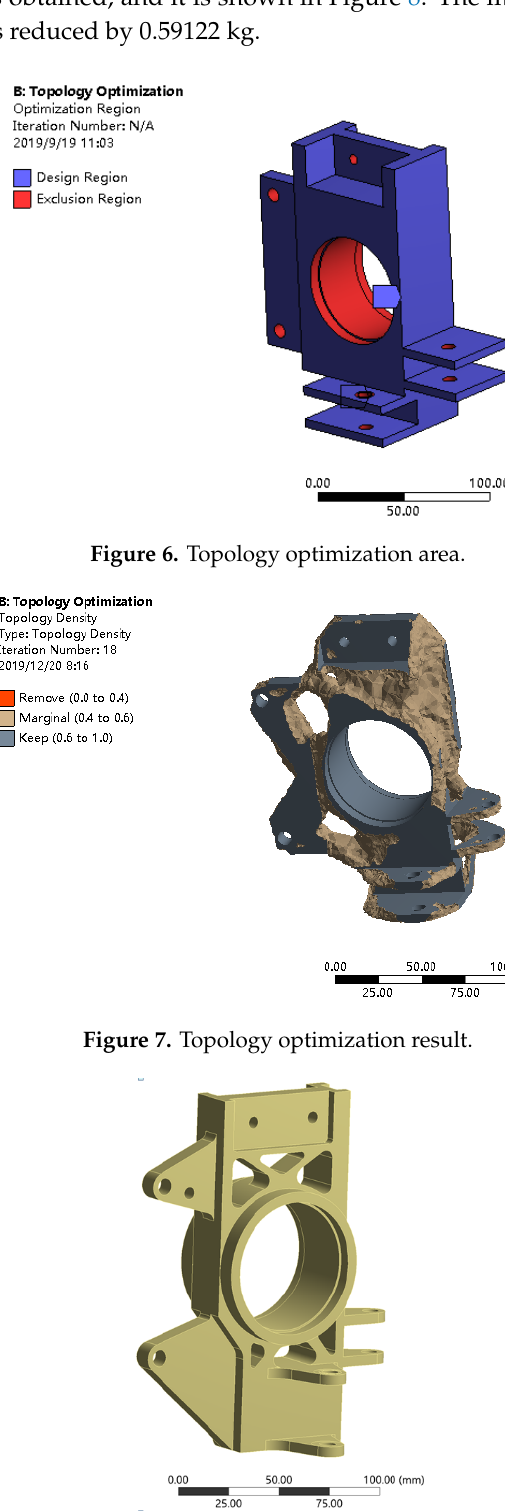
Figure 8. Geometric model after initial optimization.